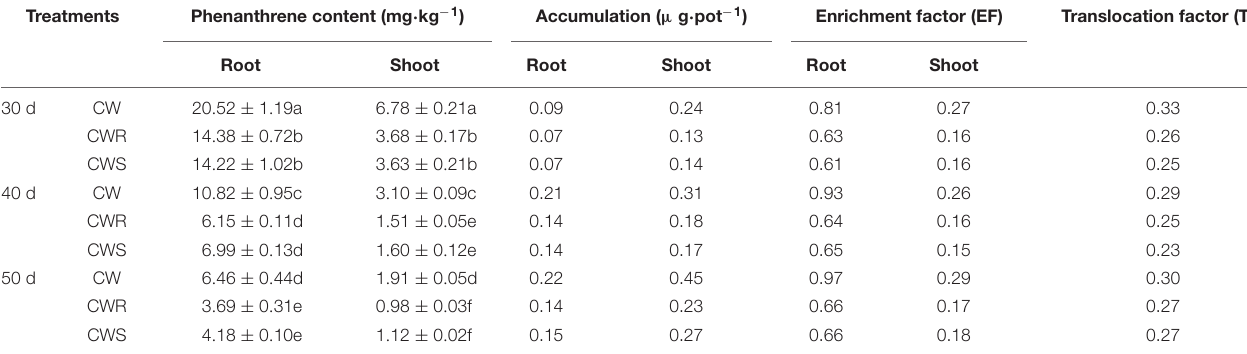
TABLE 5 | The phenanthrene content and accumulation in white clover in different treatments after inoculation with strain Phe15 for 30, 40, and 50 d. Treatments